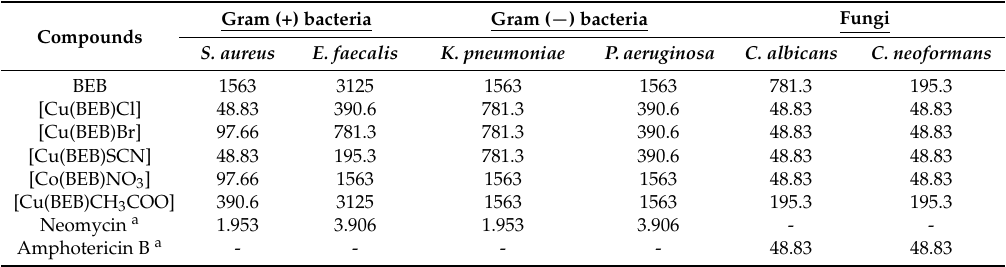
Table 5. Schiff base ligand [BEB] and its Cu(II) complexes minimum inhibitory concentration (MIC) ( µ